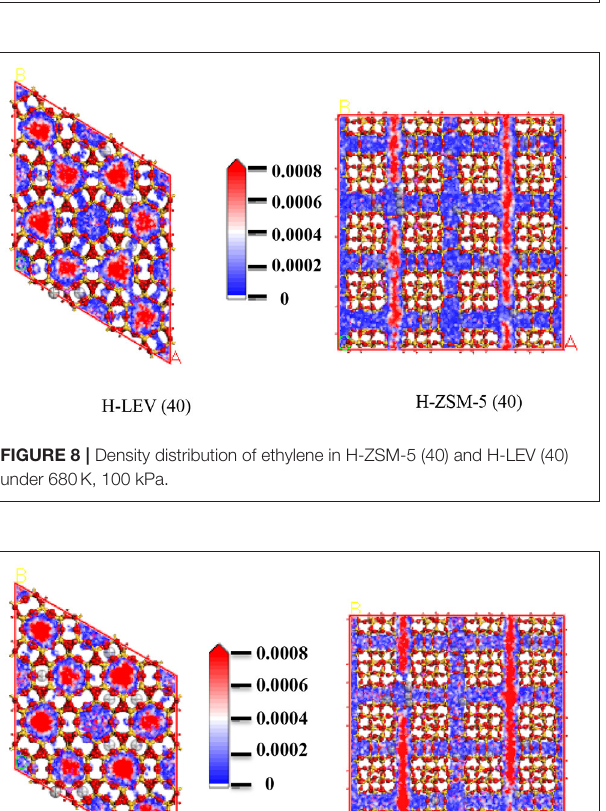
and propylene have higher adsorption amounts in H-LEV